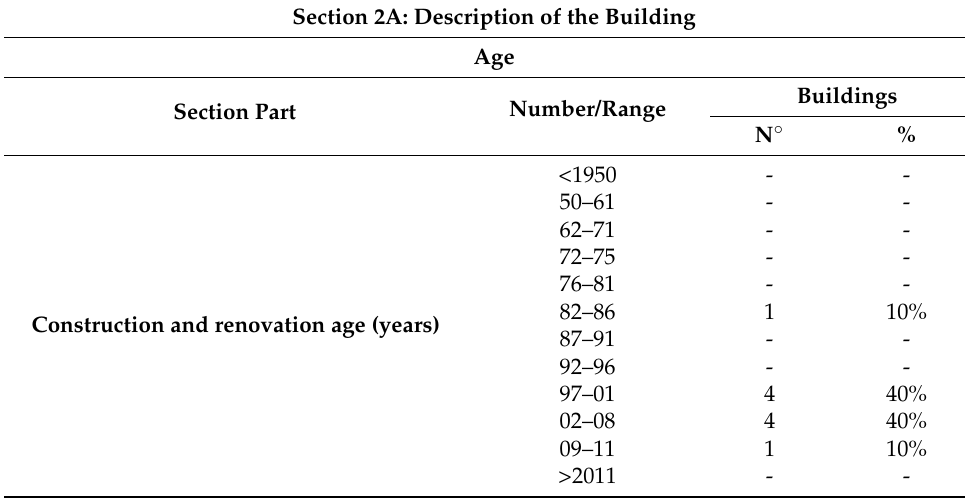
Table 9. Section 2 CARTIS-Building. Case studies characterization: Age—Synoptic